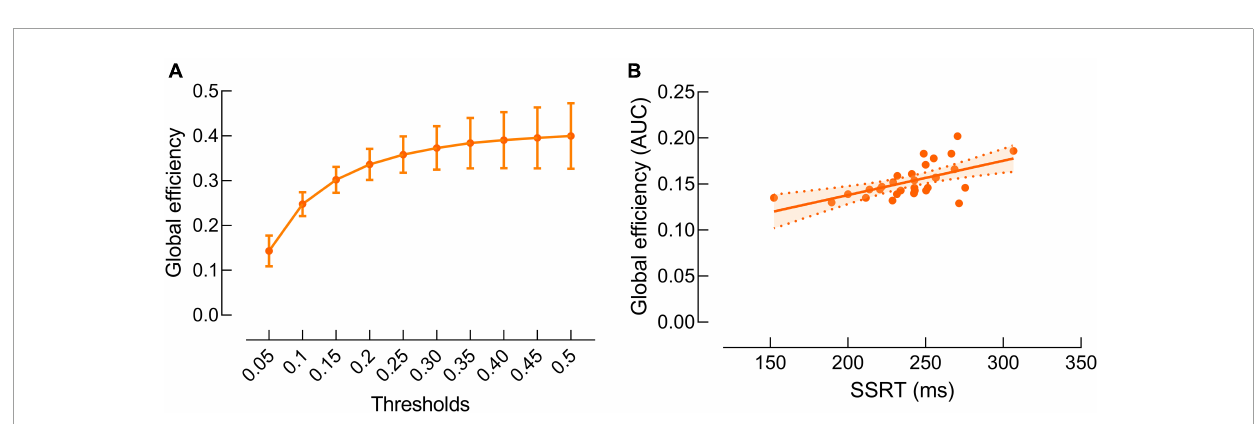
FIGURE4 Correlations between beta band global efficiency and stop-signal reaction time (SSRT). (A) Beta band global efficiency at each threshold. Data are presented as mean and standard error. (B) Significant positive correlation between beta band global efficiency and SSRT. Data are presented as areas under the curves of global efficiency at all